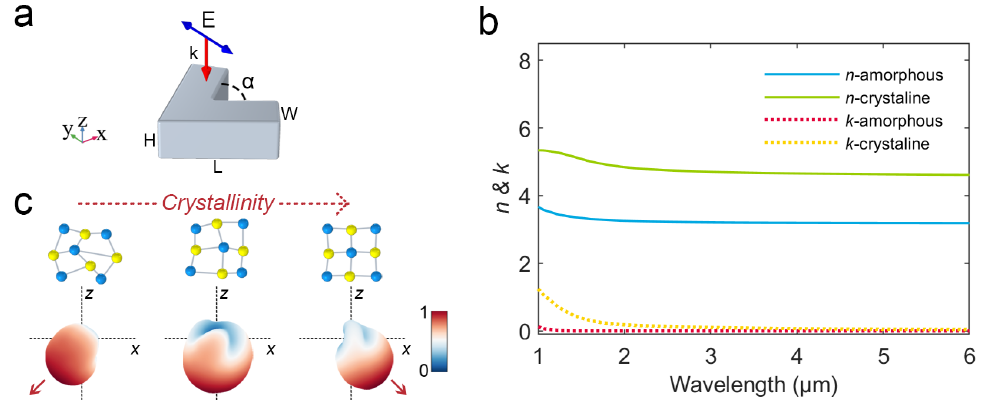
Figure 1. Calculation model and refractive index parameters of phase-change material: ( a ) Schematic diagram of the V-shaped phase-change antenna geometry and the incident light direction; ( b ) Com- plex refractive index of amorphous (0%) and crystalline (100%) GSS4T1 phase-change materials; ( c ) Conceptual illustration of V-shaped phase-change antenna for continuous reconfigurable radiation